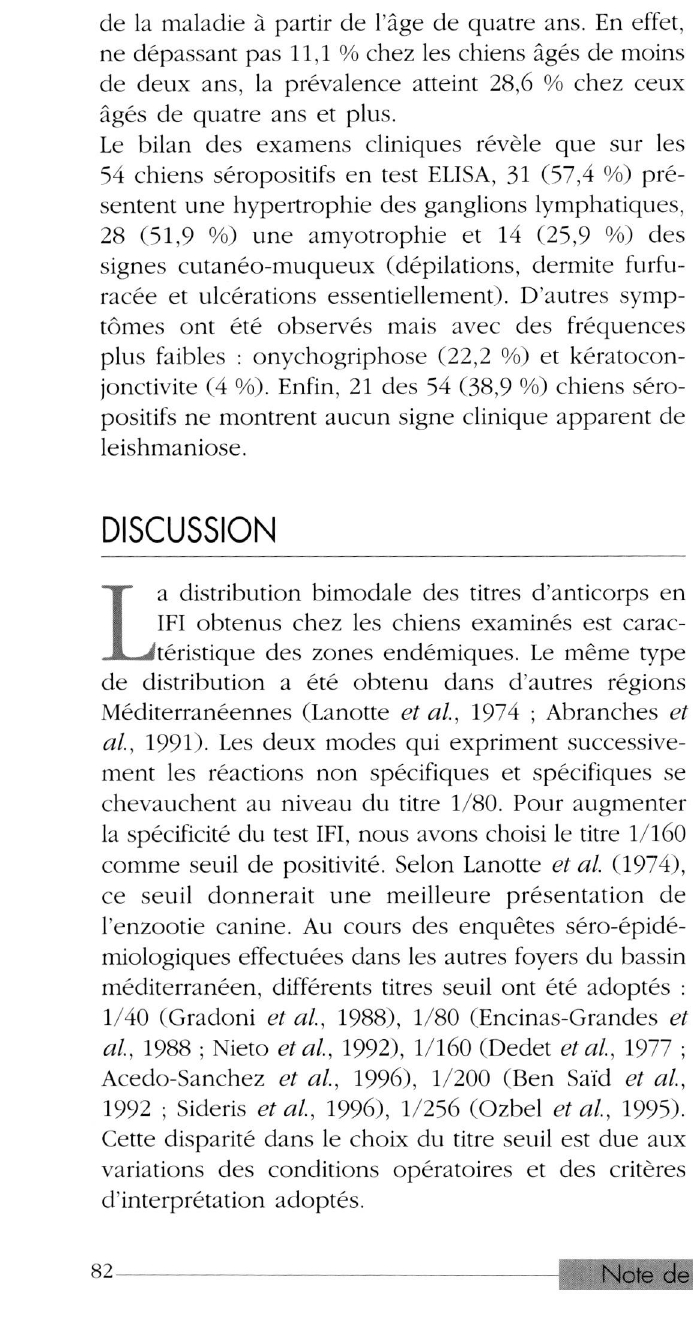
Fig. 3. - Comparaison des résultats des tests IFI et ELSA.